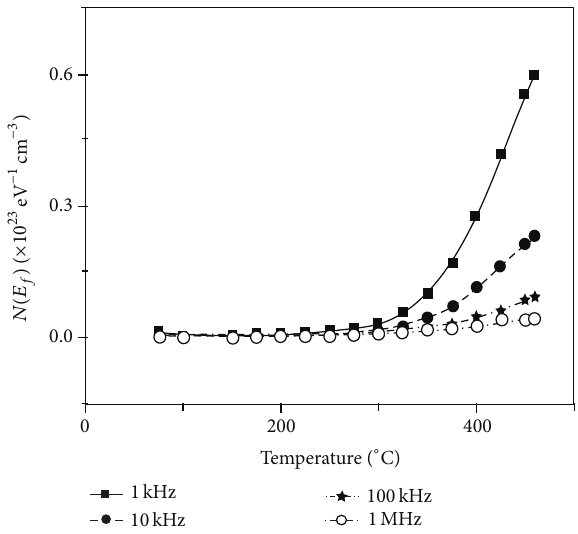
Figure 10: Variation of density of states at Fermi level of PGT ceramic with